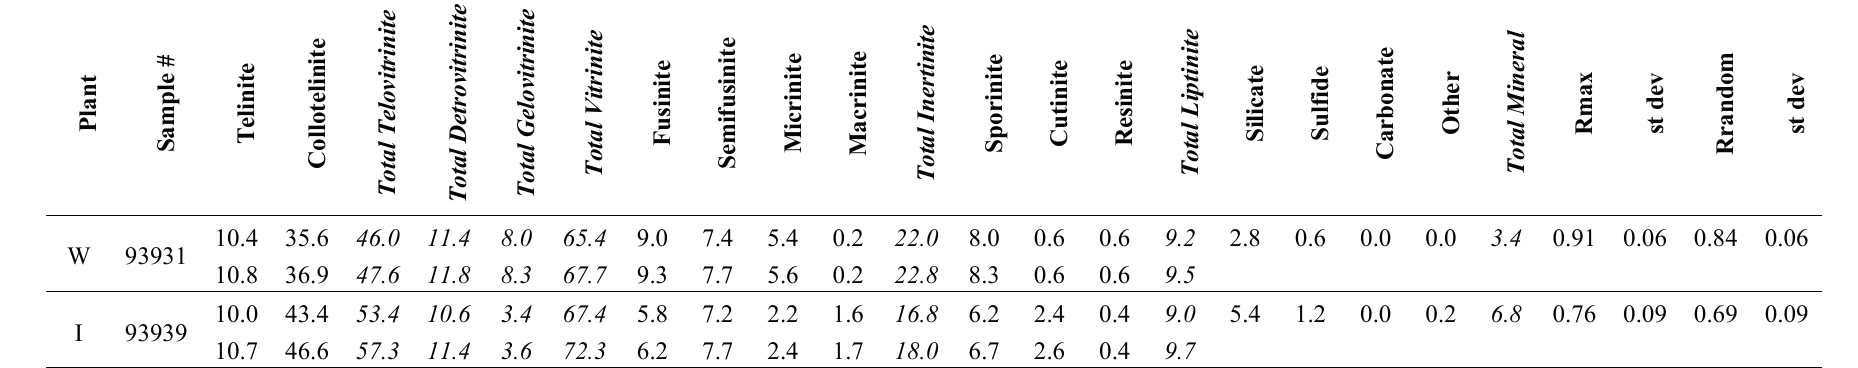
Table 3. Feed coal petrology. Macerals not encountered are not listed in the table. Note that the vitrinite maceral subgroups are totaled along with the total vitrinite percentage. The inertinite, liptinite, and mineral percentages are listed along with the individual percentages of the macerals and minerals. Vitrinite maximum (Rmax) and random (Rrandom) reflectances and their respective standard deviations are also listed for each coal.